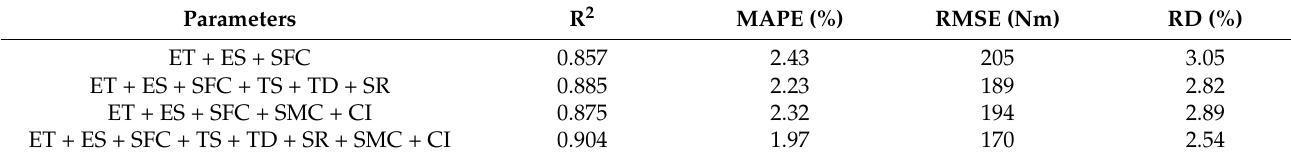
Figure 6. Results for ANN-based axle torque estimation model development, comparing estimated values against measured axle torque: ( a ) as a function of the engine parameters; ( b ) as a function of the engine parameters and major tractor parameters; ( c ) as a function of the engine parameters and soil physical properties; and ( d ) as a function of the engine parameters, major tractor parameters, and soil physical properties. Table 5. Performance on the calibration set for the ANN-based axle torque estimation models.